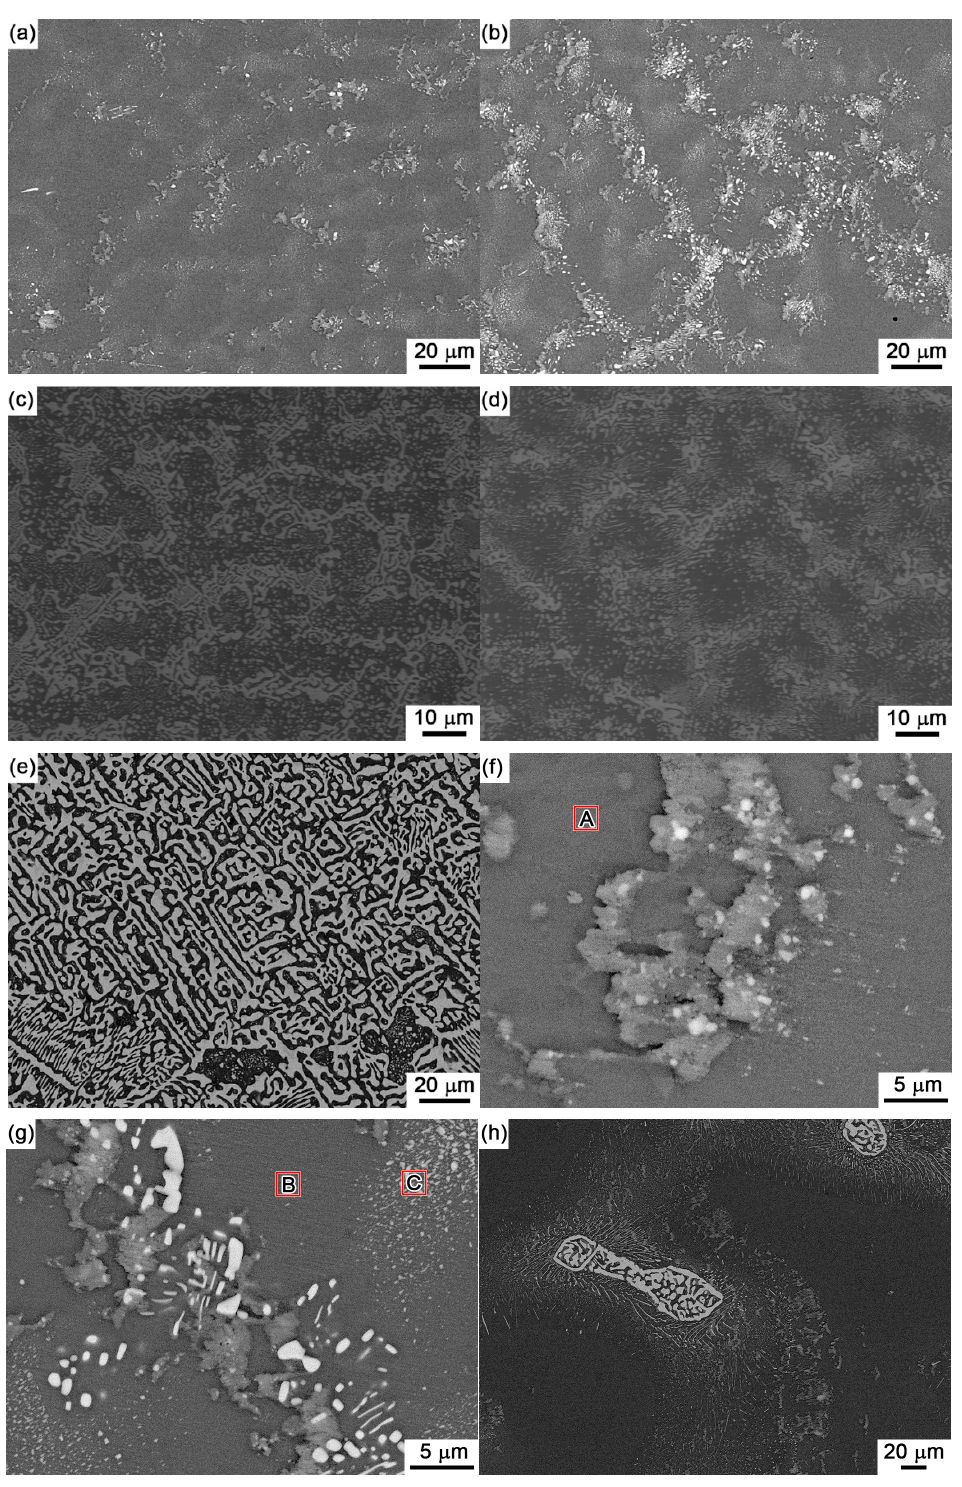
Figure 4. SEM images on the microstructure of Sn-Bi solder alloy: ( a ) Sn-5Bi; ( b ) Sn-15 Bi; ( c ) Sn-30Bi; ( d ) Sn-45Bi; ( e ) Sn-58Bi; ( f , g ) higher magnification on Sn-5Bi and Sn-15Bi solder; and ( h ) Sn-15Bi with furnace cooling.